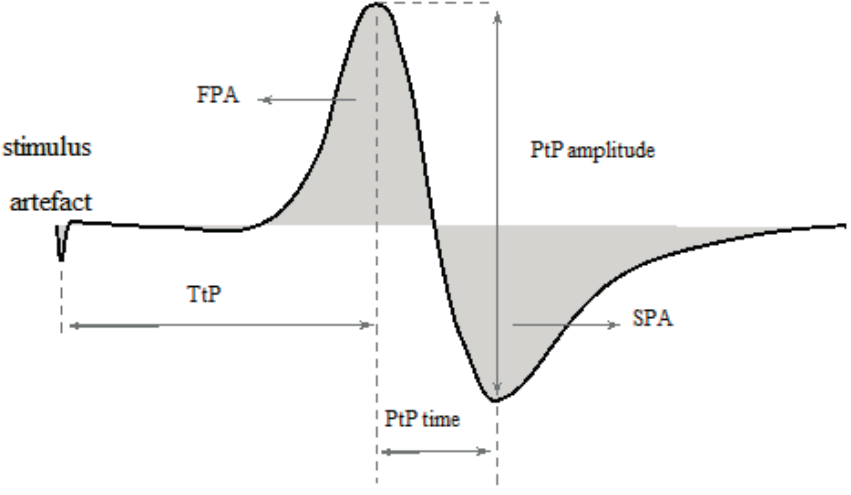
Figure 5. The general representation of M-wave and some of the commonly extracted parameters: peak-to-peak amplitude (PtP), time between peaks (PtP time), time to peak (TtP), first peak area (FPA), second peak area (SPA) [51]. Typical, in time domain, the amplitude variables of an M-wave are voltage values detected from specific points of the signal, normally the peaks. The M-wave amplitude is essentially a reflex of the magnitude of the sum of individual Motor Unit Action Potentials (MUAPs)